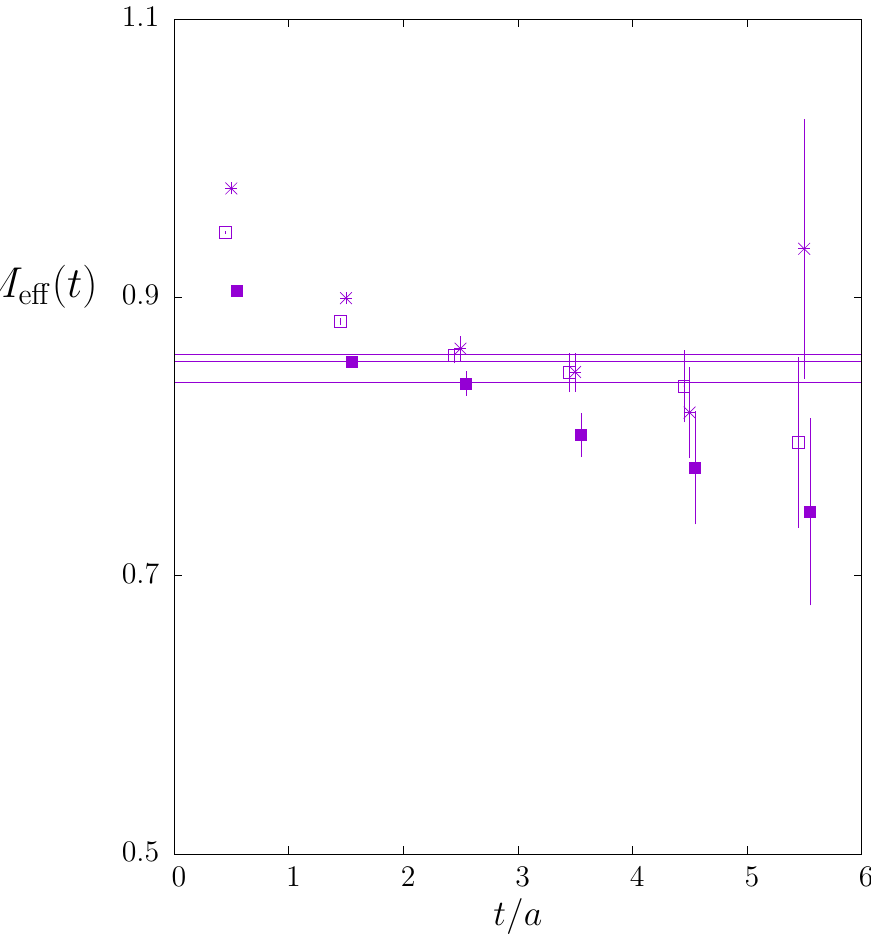
Figure 10 . Effective masses for the J PC = 2 −− ground state; 2 of the 5 components from the E representation ( (cid:4) ) and the other 3 from the T 2 representation ( (cid:3) ). Also the triply degenerate J PC = 1 −− ground state ( ? ). Some points shifted for clarity. Horizontal lines are our best mass estimates. On the 38 4 lattice at β = 6 . 50